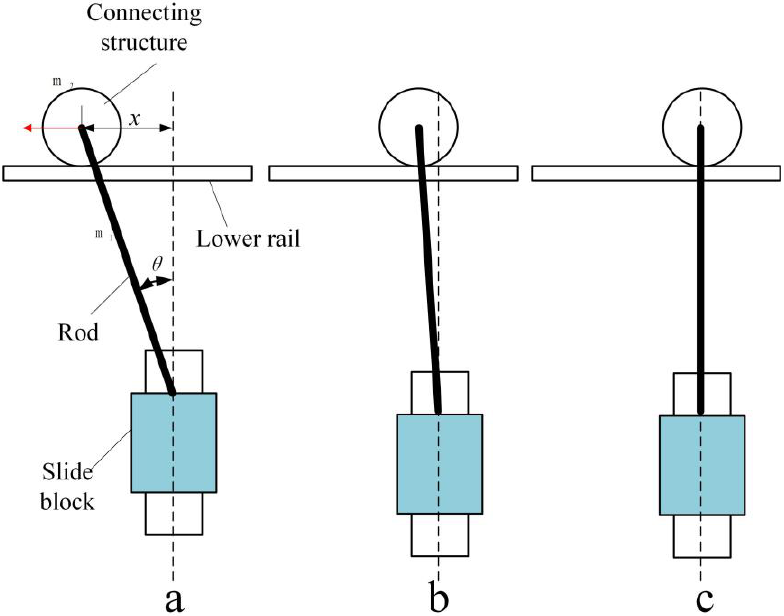
Figure 23. Movement process of blades in a single cycle when using new force decoupling device.